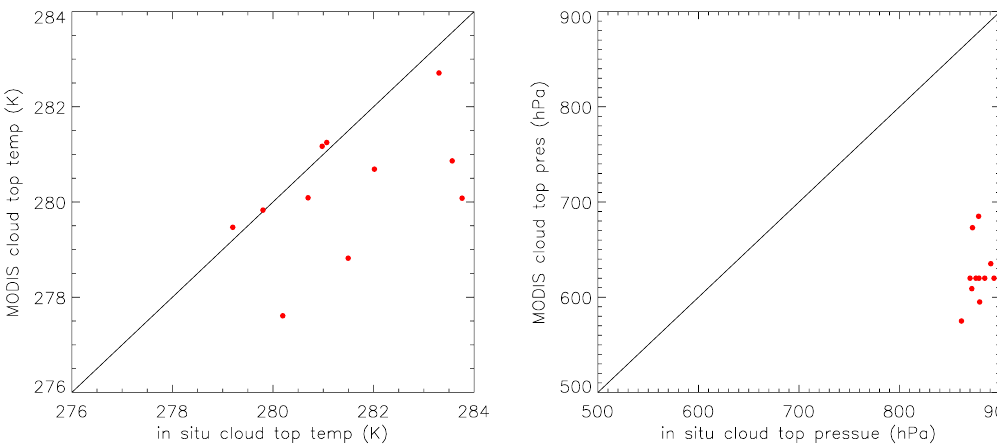
Fig. 10. Comparison of MODIS and in situ cloud top temperatures and